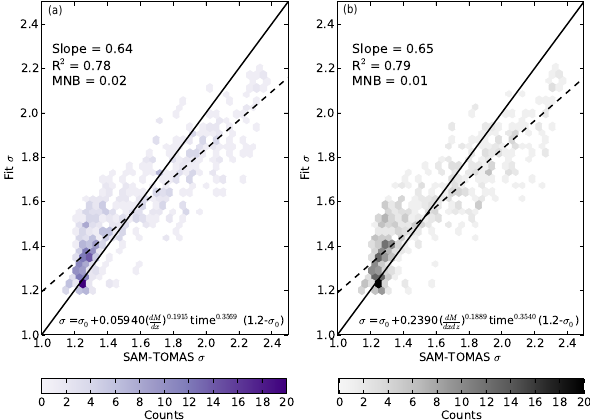
Figure 10. One-to-one plot showing simplified σ fits vs. SAM- TOMAS for (a) d M/ d x and (b) d M/ d x d z . The solid black line is the one-to-one line. The dashed black line is the line of best linear fit. N =